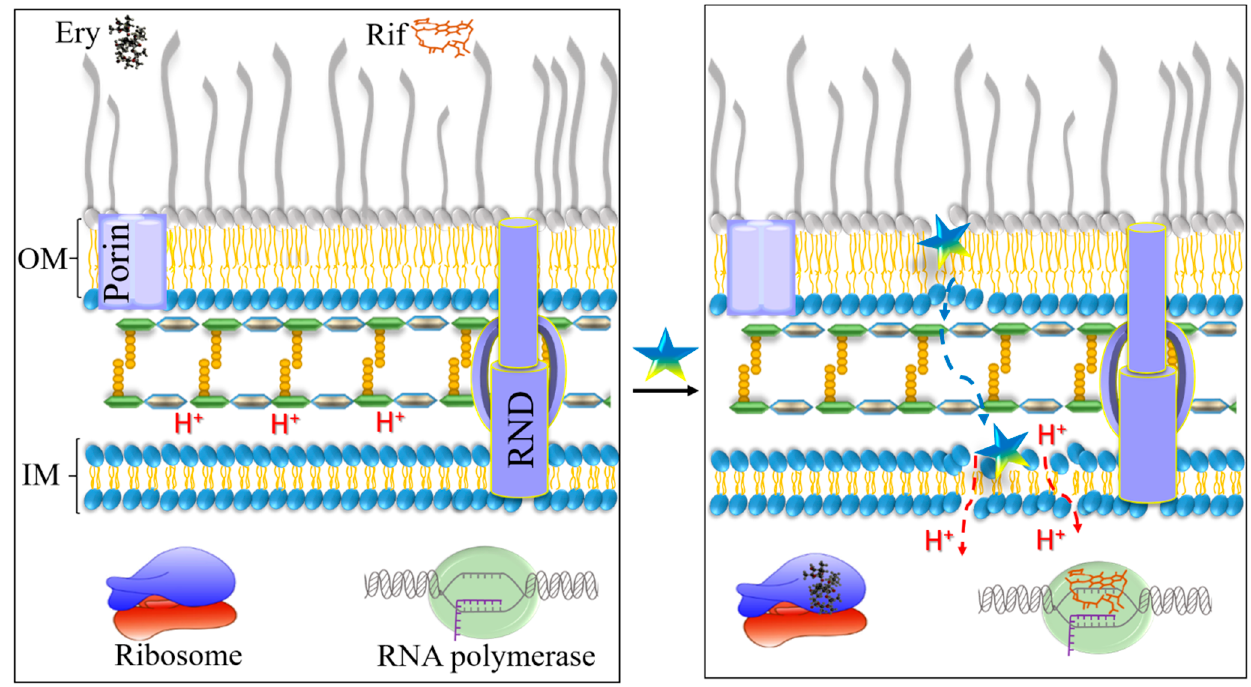
Figure 8. Proposed mechanism for GNB sensitization by facilitating drug interactions with their cytoplasmic targets. The left panel depicts the general organization of the two-membrane system prevailing in GNB cell wall. The outer membrane (OM) and inner membrane (IM) are separated by a peptidoglycan-containing periplasmic space where protons (H + ) normally accumulate to support the trans-membrane potential. Porin and RND, respectively, represent a passive and an energy- dependent metabolic protein gate. Hydrophobic antibiotics such as rifampin (Rif) and erythromycin (Ery) are depicted floating above the OM layer, to reflect their low permeability, impeding interaction with their cytoplasmic targets (the RNA polymerase and ribosome, respectively). The right panel highlights the reported effects of C 14( ω 5) OOc 10 O (represented by a pentameric star): initially, the lipopeptide destabilizes the OM thereby facilitating OM translocation of itself and that of low permeability antibiotics. Its subsequent superficial interaction with the IM would partially perturb various IM-linked functions such as active transport, hence the observed potentiation of efflux substrates, allegedly resulting from cytoplasmic accumulation, as exemplified by